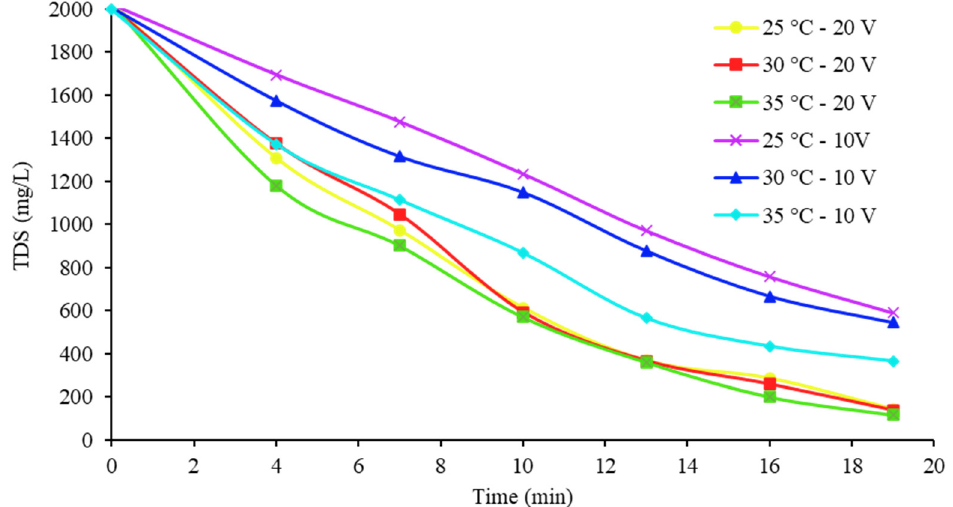
Figure 10. Desalination of the 2000 mg/L TDS samples at the chosen temperatures and initial con- centrations.